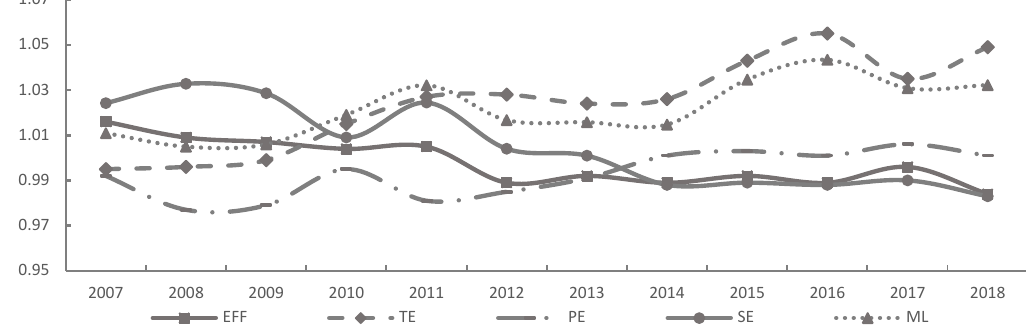
Figure 6. The indices of ML, EFF, PE, SE, and for the three regions in China, 2006 to 2018. Note: Data is calculated and processed from this